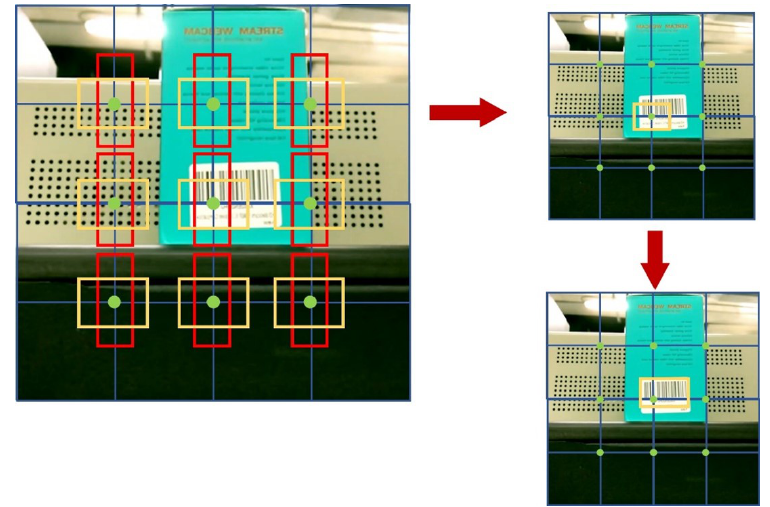
Figure 7. Two anchor boxes tiled in a 4 × 4